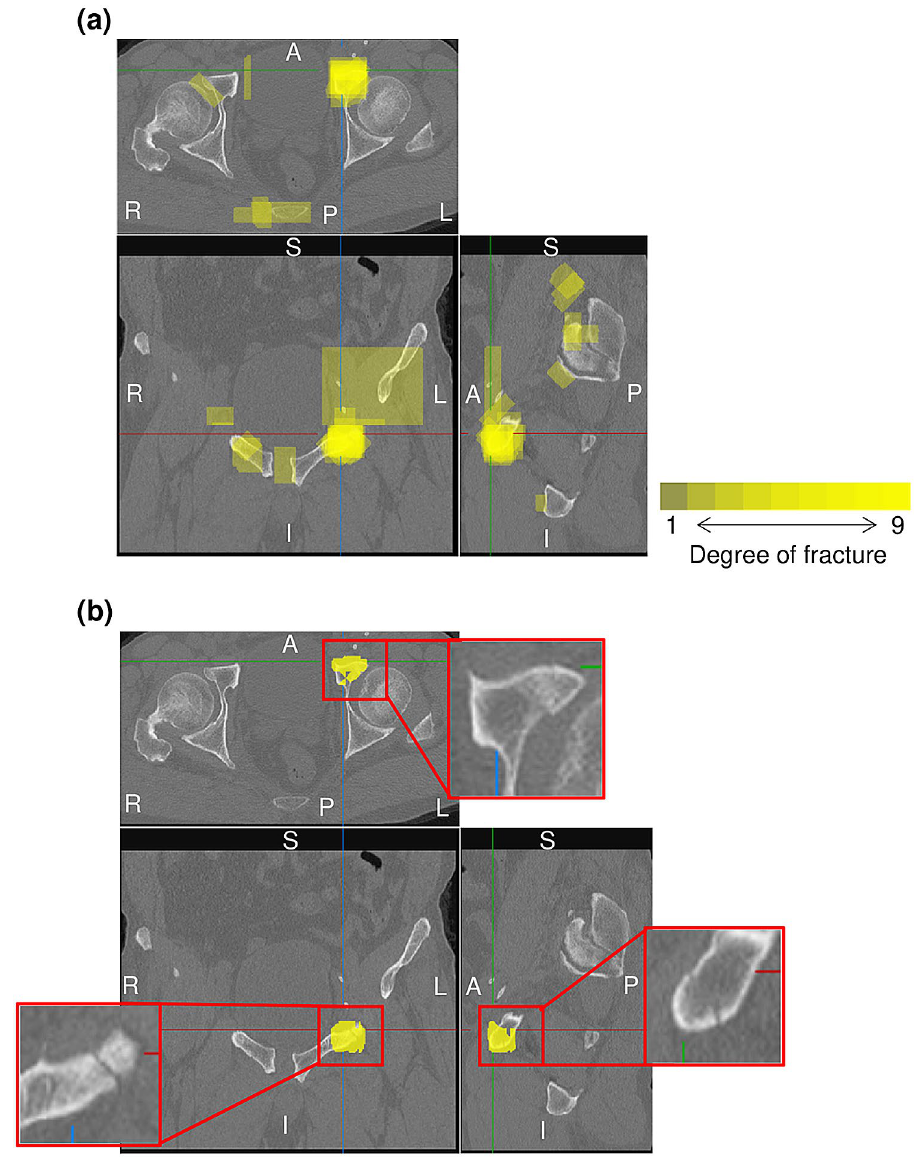
Integrated 3D fracture candidate region overlapping on CT images ( C th : 0.2). Yellow represents the degree of fracture. ( b ) Resultant 3D fracture region ( I th : 6). Yellow represents the detected region. The enlarged image shows raw CT images for the detected fracture